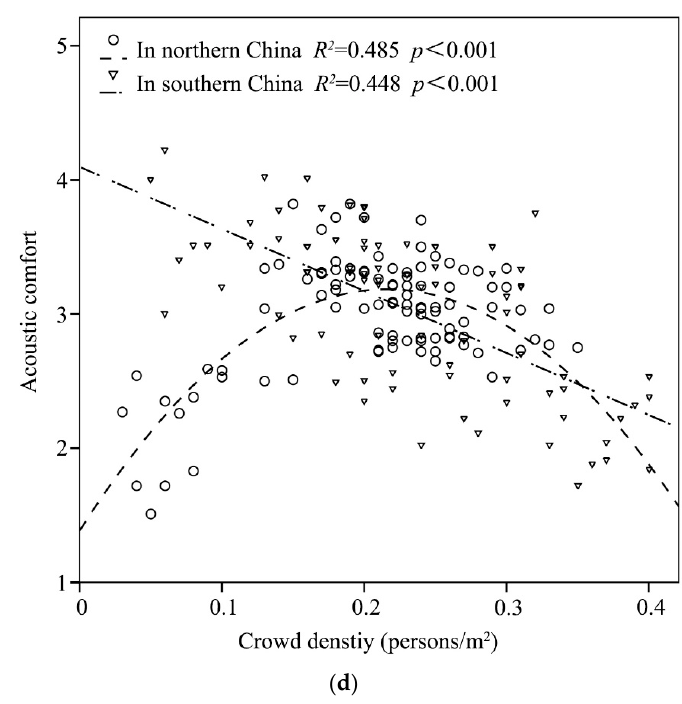
Figure 7. The influence of shop openness: ( a ) the relationship between crowd density and the number of talkers; ( b ) the relationship between crowd density and the level of sound pressure; ( c ) the relationship between crowd density and loudness; ( d ) the relationship between crowd density and acoustic comfort.